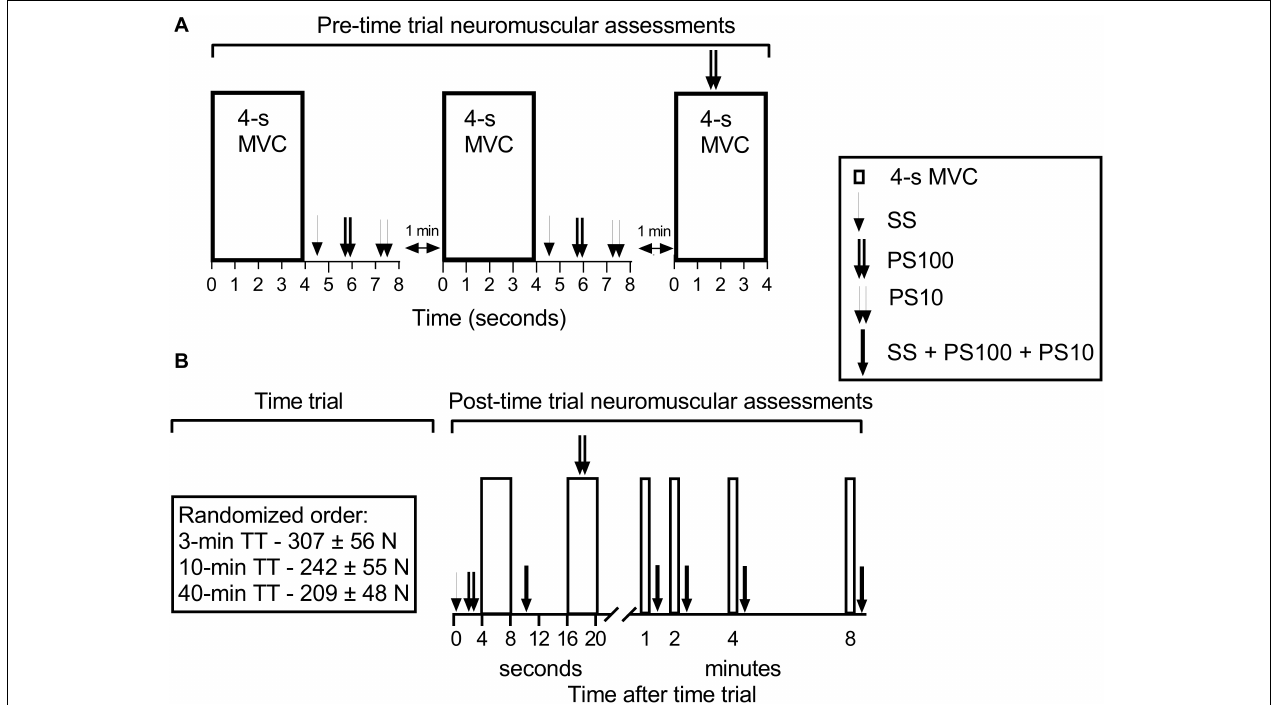
FIGURE 1 | Schematic view of the protocol. (A) The neuromuscular function assessed prior to the TTs. MVCs were performed three times with a 1-min break between MVCs. SS, PS100, and PS10 were assessed after the first two MVCs, and PS100 (superimposed doublet) was applied during the third MVC. (B) The three time trials in randomized order, followed by assessment of neuromuscular function (MVC + electrical stimulation after 4–8 s and 1, 2, 4, and 8 min, MVC with superimposed doublet after 16–20 s). MVC, maximal voluntary contraction; SS, single stimulus; PS100, paired stimuli at 100 Hz; PS10, paired stimuli at 10 Hz; TT, time